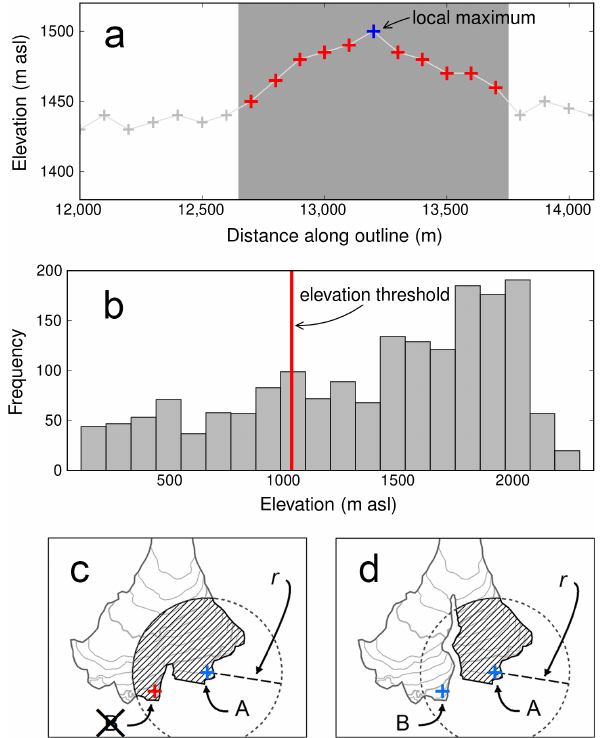
Fig. 3. Three-step procedure to identify the heads of major glacier branches. (a) Identification of local maxima along the glacier out- line by comparing each point to its five neighbors in each direction. (b) Histogram of the elevation distribution of all sampled points along the glacier outline. Only points above the elevation thresh- old are retained. (c, d) Glacier area covered by circle with radius r around identified head A; heads A and B are separated by less than r . In case (c) , head B (with lower elevation than head A) is elimi- nated. In case (d) , both heads are retained because the ice-free ridge completely separates the two heads (i.e., splits the circle into two disconnected